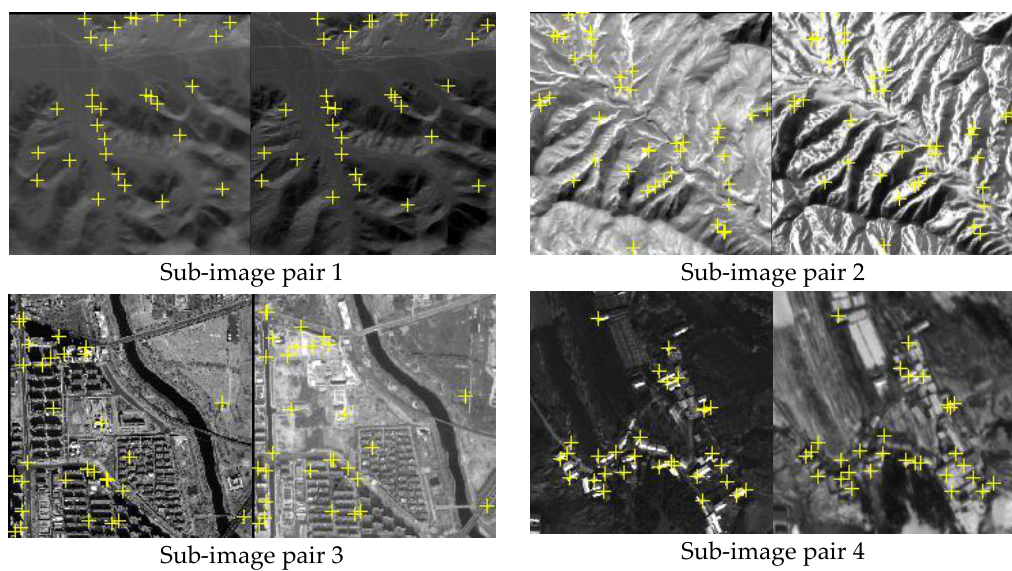
Figure 5. Manually measured tie points (yellow crosses) in four sub-image pairs.